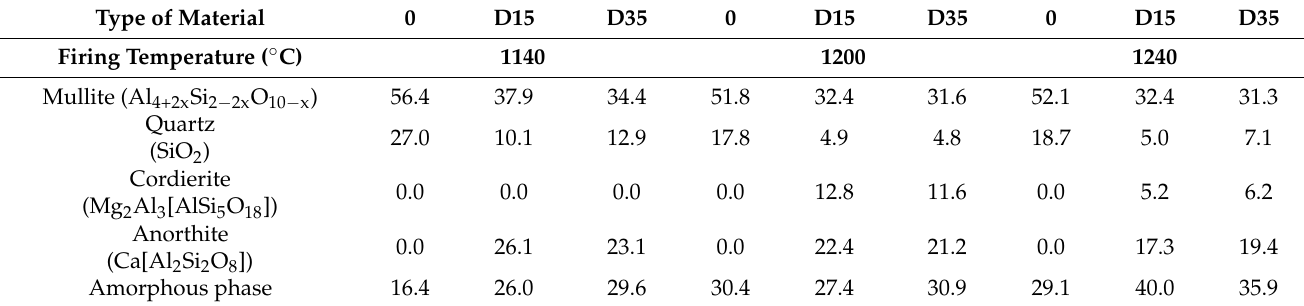
Table 5. Phase composition analysis for obtained ceramic materials fired at 1140, 1200, and 1240 ◦ C. Type of